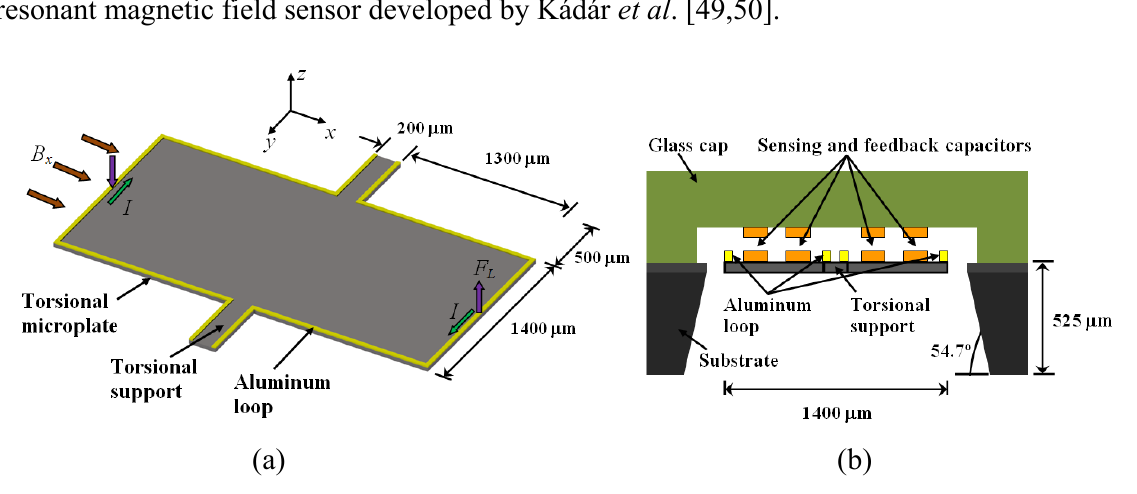
resonant magnetic field sensor developed by Kádár et al .